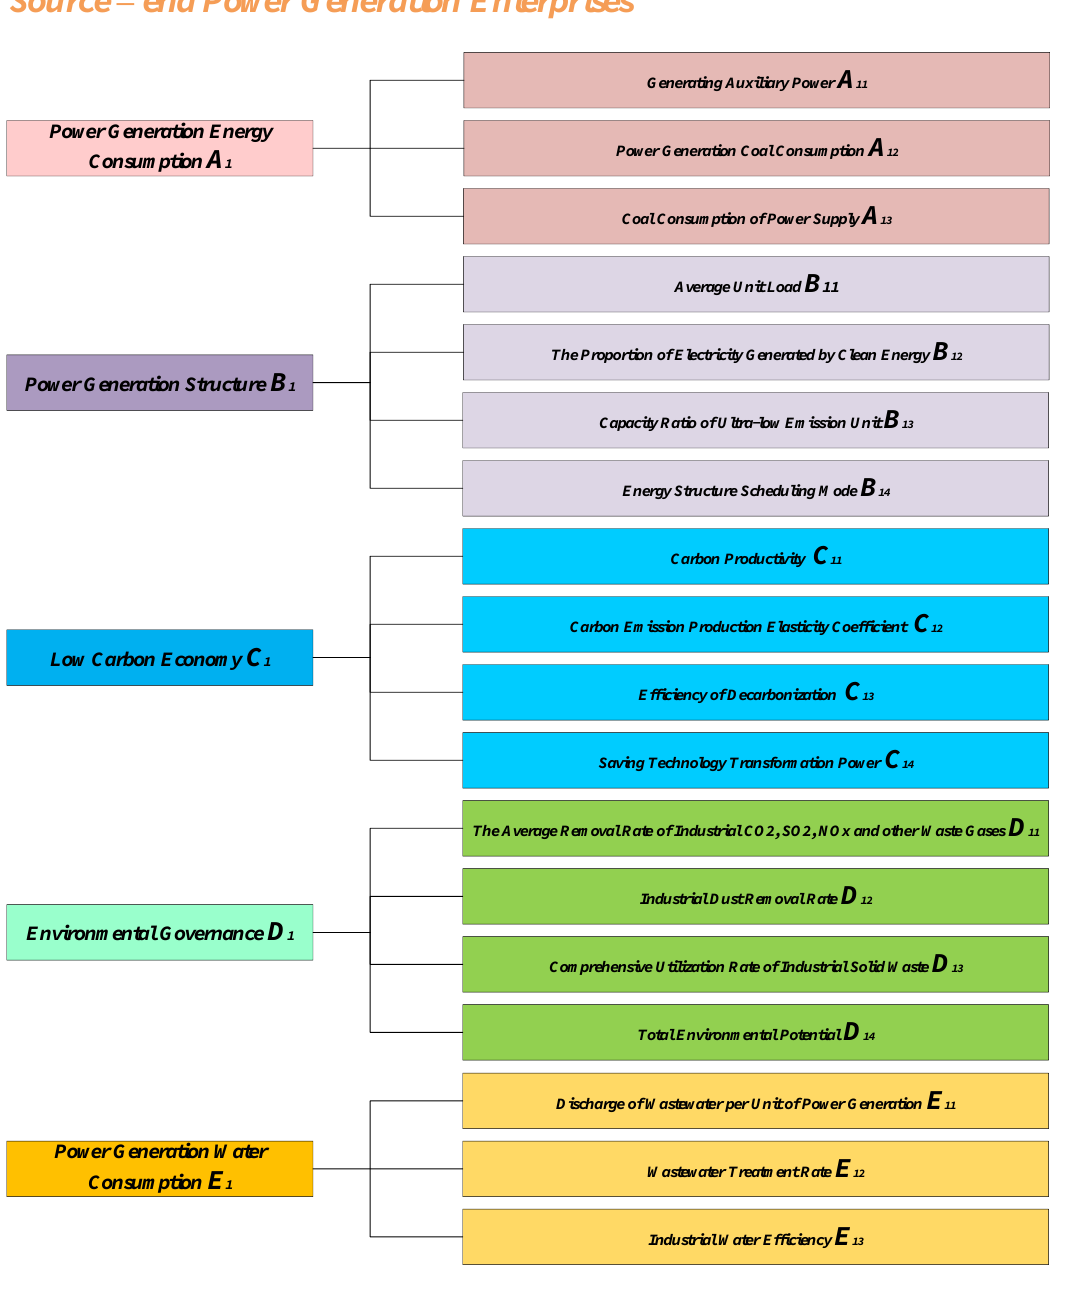
Figure 2. Source-end coal power carbon emission comprehensive index system.